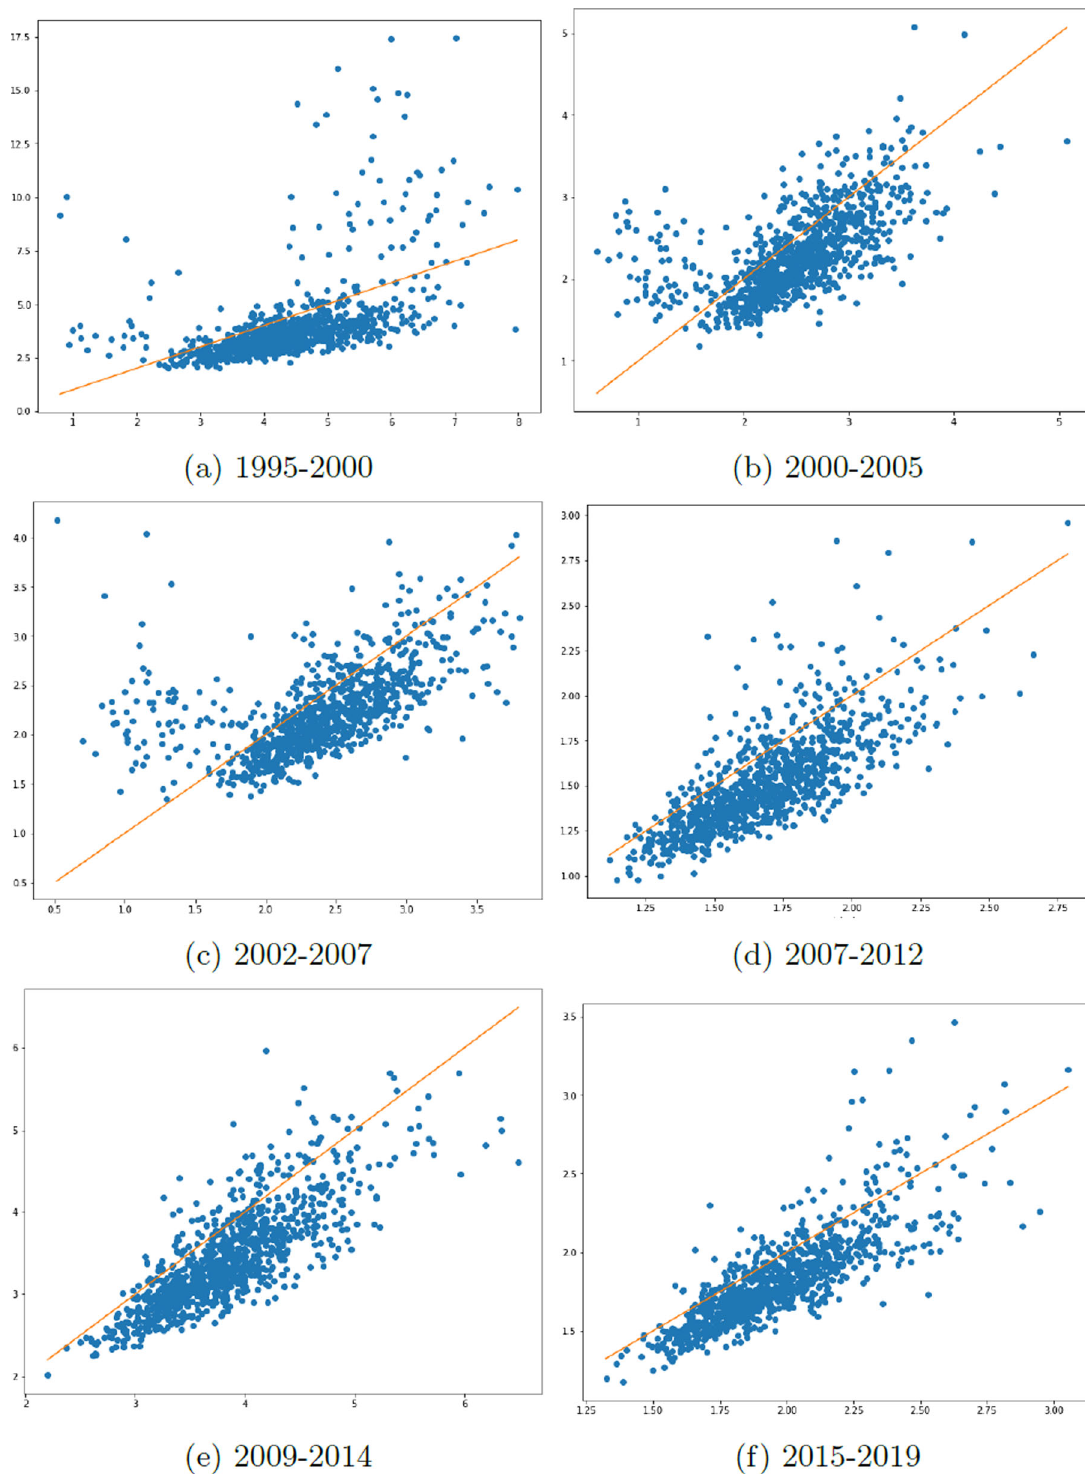
Fig. 1 End value of one dollar after 5 years for multiple samples. The fi rst coordinate is the constrained portfolio, while the second coordinate is the unconstrained